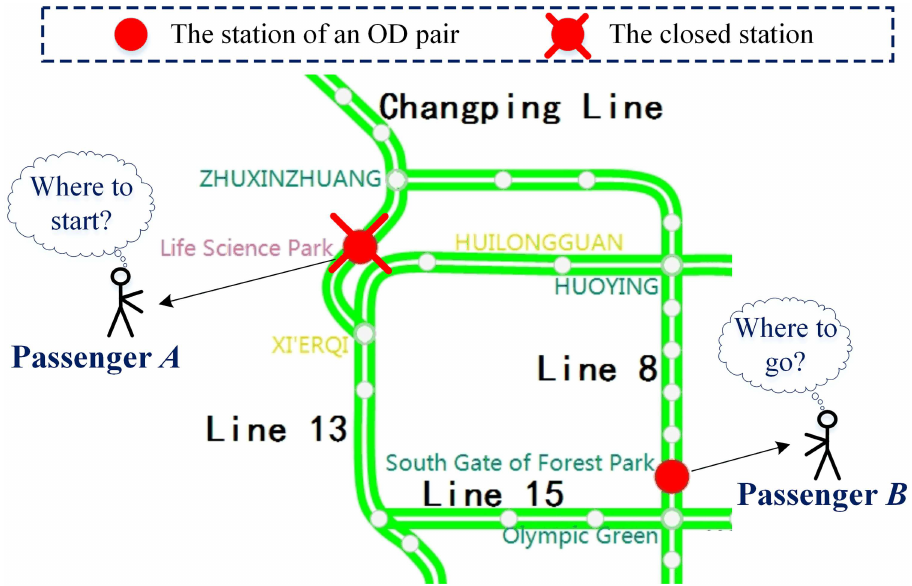
Fig 3. An illustration of assumption 2. For a particularrail passenger, O and D denote the planedorigin and destination stations, respectively. O’ denotesthe alternative origin station when the planedorigin station is closed, and D’ denotes the alternativedestination station when the planeddestinationstation is closed. ( a ) represents the passenger’s plannedrail journey in the normalsituation. ( b ) shows that the passengerwill take a bus or taxi to the new alternativeorigin station and will then take rail transit from the new origin station to the planneddestination when the plannedorigin station is closed. ( c ) shows that the passengerwill take rail transit